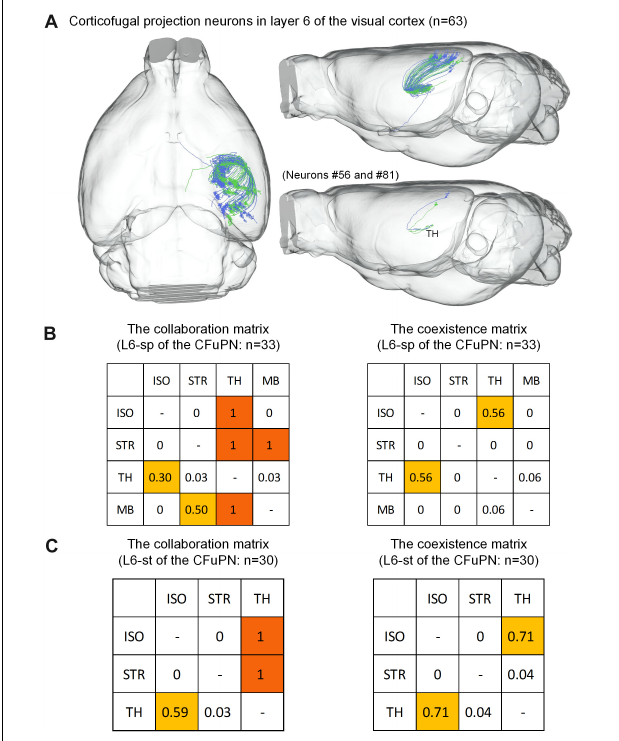
FIGURE 6 | Distribution of axon terminals for the CFuPN in L6. (A) The 63 CFuPN in L6 with their complete morphologies are shown in the mouse brain. In the bottom right of panel (A) , two representative L6-sp (#56) and L6-st (#81) neurons show their axonal terminals in thalamus. (B) The collaboration and coexistence matrices of L6-sp. L6-sp in corticofugal projection neurons: n = 33. (C) The collaboration and coexistence matrices of L6-st. L6-st in corticofugal projection neurons: n =